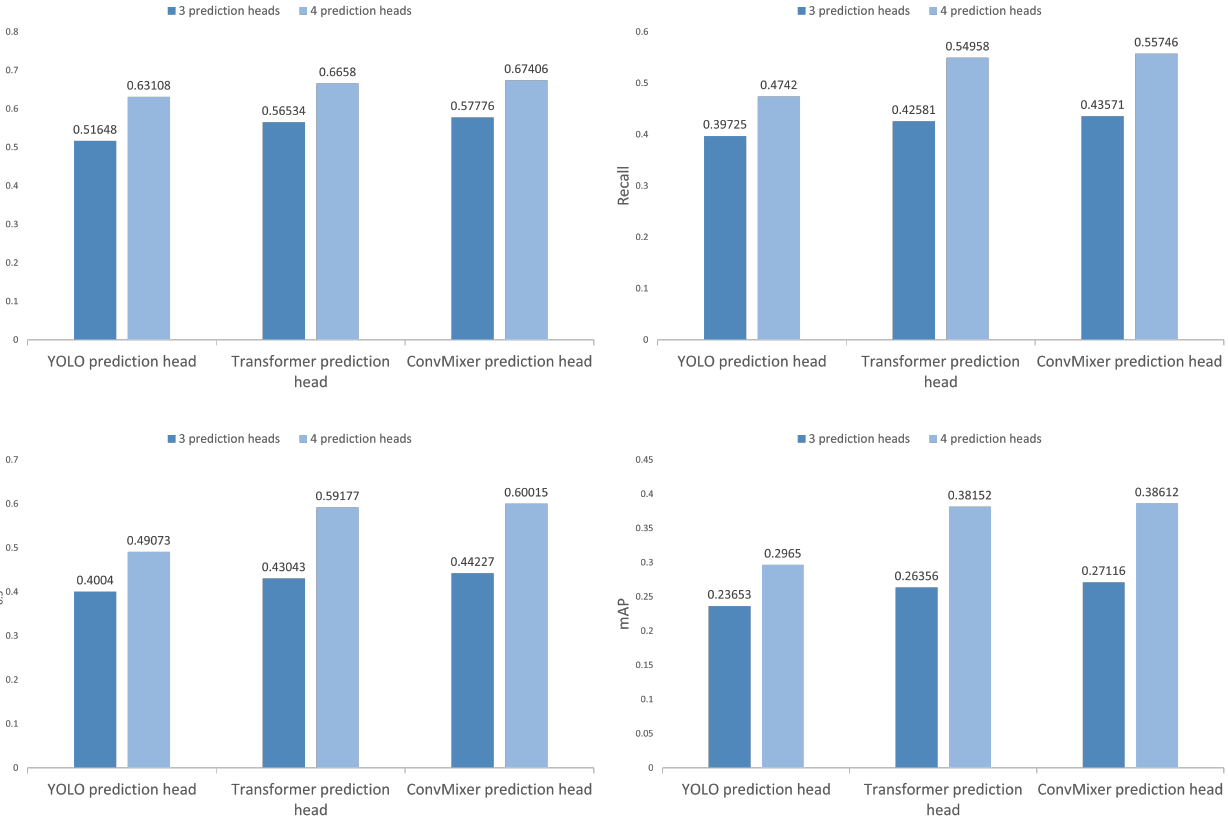
Figure 12. Comparision between the performance of the model while changing the number of prediction heads and the type of prediction